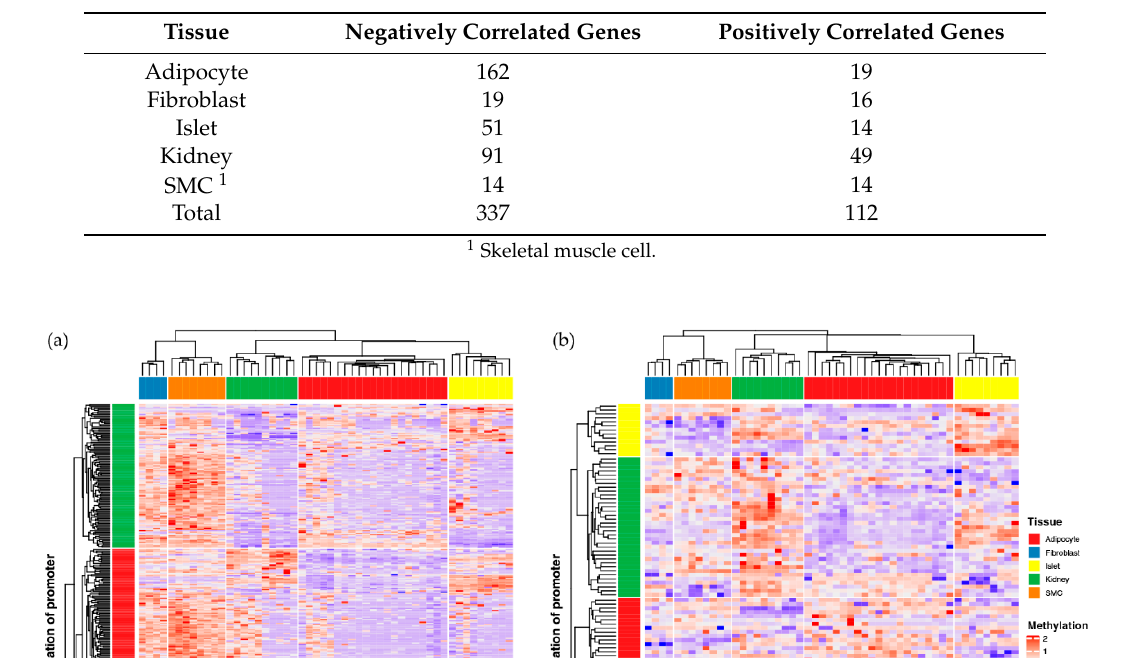
Table 1. Number of correlated genes in five di ff erent tissues.